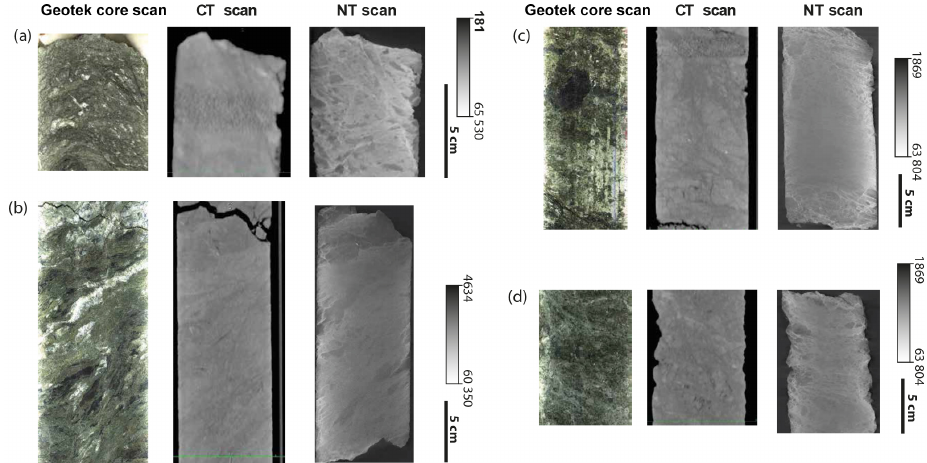
Figure 4. As for Fig. 3, but for cataclasite units. For core section intervals (borehole_core run and section_depth interval from the top of the core section in cm) (a) DFDP-1B_58-2_0-8 (depth interval 127.93–128.01m), (b) DFDP-1A_63-2_47-70 (86.48–86.71m), (c) DFDP-